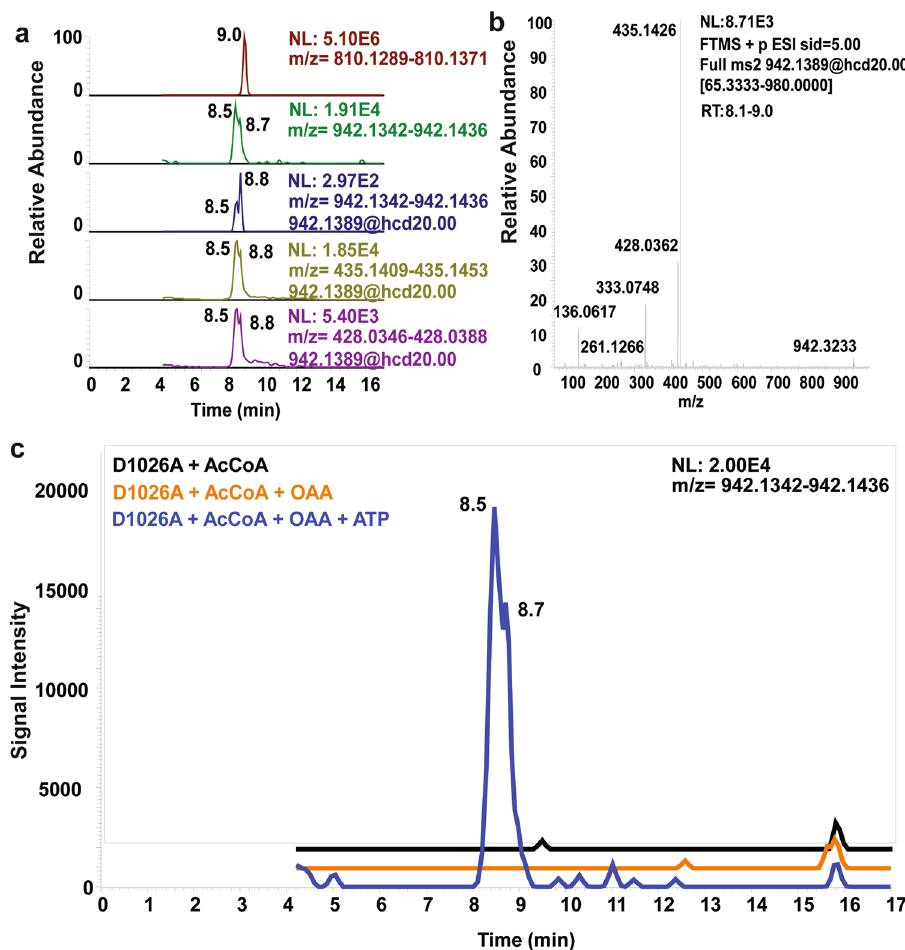
c LC-HRMS chromatograms ofthe citryl-CoAproductfrom ACLY-D1026A+AcCoA (black), ACLY-D1026A+AcCoA+OAA (orange), and ACLY-D1026A+AcCoA+ OAA+ATP(blue).Anintensepeakcorrespondingtocitryl-CoAwasidenti fi edinthe only extract from ACLY-D1026A+AcCoA + OAA+ATP with the baseline offset for